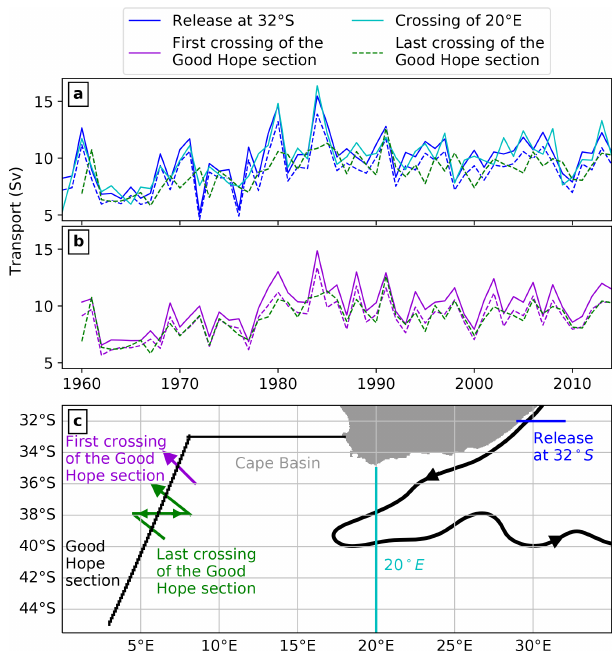
Figure 4. Comparison of the year of reference used to calculate a time series of the Agulhas leakage transport for experiment P: time series of Agulhas leakage transport referenced to the release year (blue in a ), year of crossing 20 ◦ E (cyan in a ), year of the first cross- ing of the Good Hope section (purple in b ) and year of last crossing of the Good Hope section (green in a + b ). Dashed lines show the combined transport of all particles that cross the Good Hope sec- tion an odd number of times, while for the solid lines this additional criterion was not applied. (c) Schematic path of the Agulhas Cur- rent via the retroflection into the Agulhas Return Current (black ar- row) and all the sections used for assigning the reference date in (a) and (b) . The Cape Basin is located northwestwards of the Agulhas Retroflection and southeastwards of the Good Hope